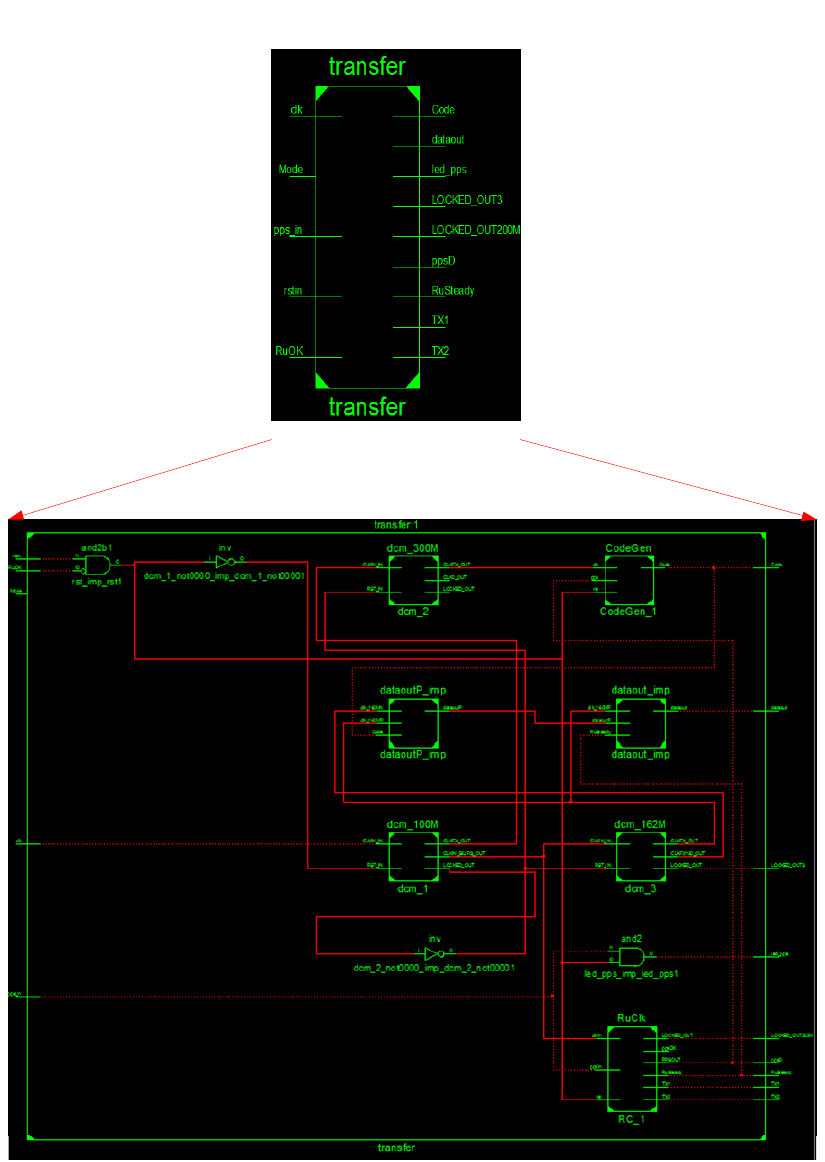
Figure 7. The schematic diagram of the signal generating module at RTL level based on FPGA.